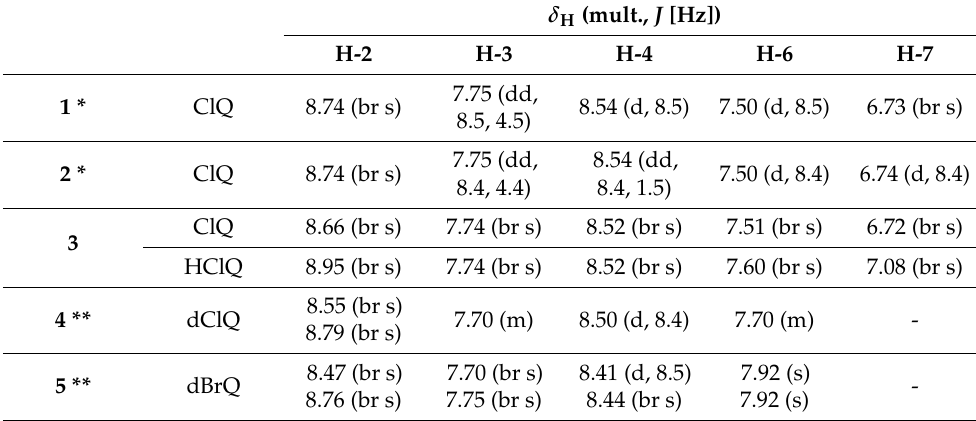
Table 1. 1 H NMR (600 MHz, DMSO-d 6 ) chemical shifts δ H [ppm] for 1 – 5